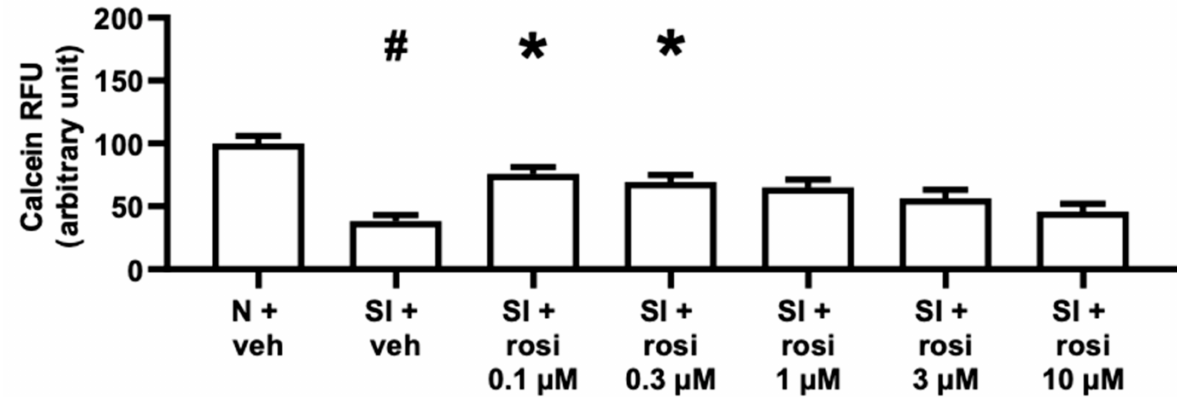
Figure 6. Cell viability under normoxic and simulated ischemic conditions with or without varying concentrations of rosiglitazone. Results are presented as mean with standard error. ( a ) Adult rat cardiomyocytes. The normoxia (N) + vehicle group was set to 100% relative fluorescent units (RFU), and all data were normalized to the averaged simulated ischemia (SI) + vehicle group. (Mann– Whitney test, # p < 0.05 vs. N + vehicle, n = 9, 38 technical replicates) ( b ) Adult rat cardiomyocytes. The SI + vehicle group was set to 100% RFU, and all of data were normalized to the averaged SI + vehicle group. (Kruskal–Wallis, Dunn’s post hoc, * p < 0.05 vs. SI + vehicle, n = 4–9, 12–40 technical replicates) ( a , b ) Adult rat cardiomyocytes. Rosiglitazone treatment increased the viability of adult rat cardiomyocytes at 0.3 µ M during simulated ischemia. SI: simulated ischemia; N: normoxia; veh: vehicle.; rosi: rosiglitazone; RFU: relative fluorescence units.